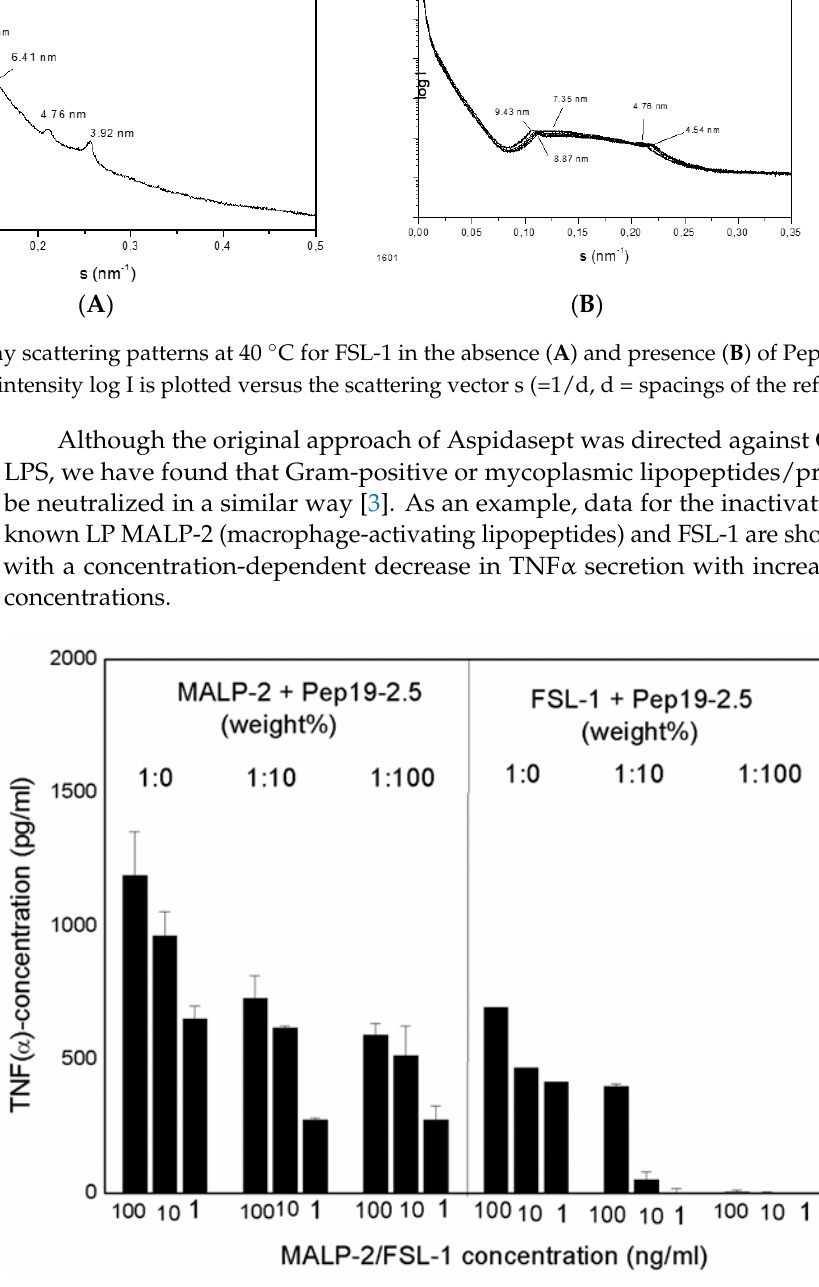
Figure 13. Stimulation of hMNC by macrophage-activating lipopeptide-2 (MALP-2) and fibroblast stimulating lipopeptide-1 (FSL-1) in the presence of increasing concentrations of Pep19-2.5. Mean values and standard deviations due to the determination of TNF α in duplicate.